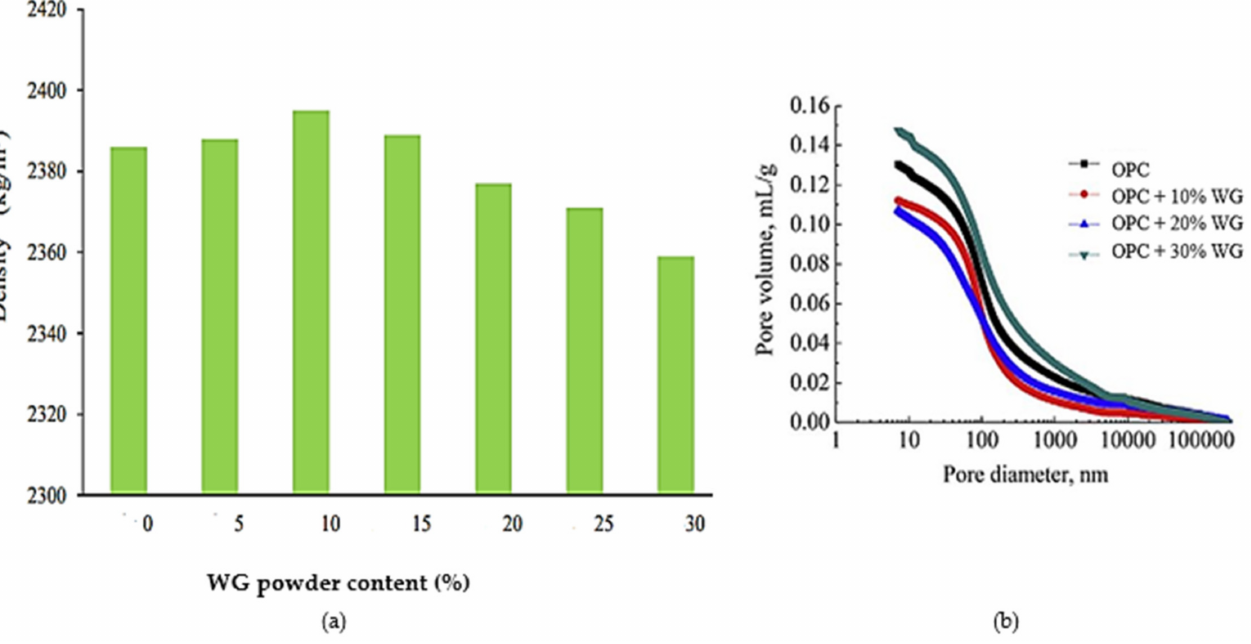
Figure 8. Density and porosity of WG powder-based concretes. ( a ) The density of concrete with WG powder (particle size < 100 µ m) [75]. ( b ) The porosity of concrete with WG powder (Particle size 8–110 µ m)